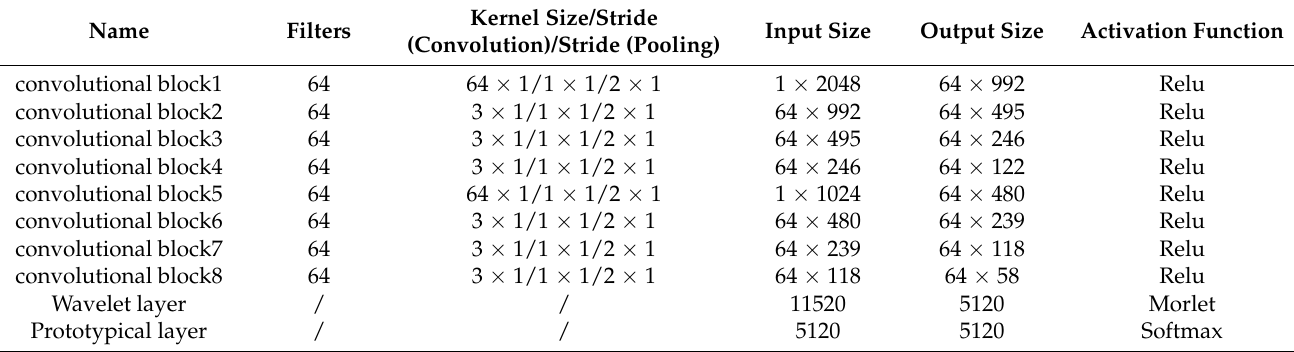
Hyperparameters setting of the wavelet-prototypical network based on fusion of time and frequency domain